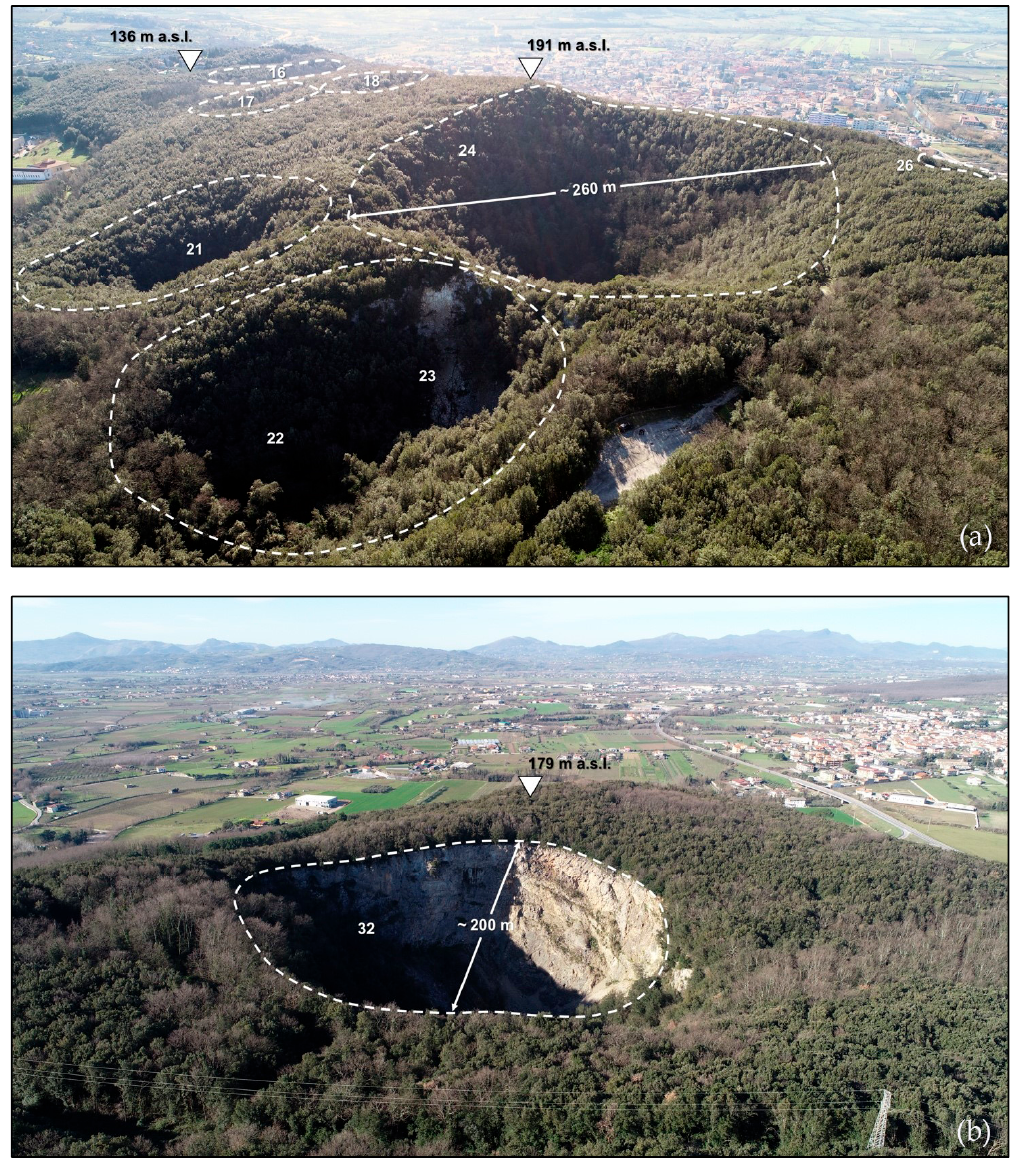
Figure 6. Drone images ( a ) and ( b ) of Montepugliano sinkholes. Dashed white lines represent the sinkhole rim. Item sinkhole numbers (16, 17, 18, 21, 22, 23, 24, 26, and 32) coincide with those in Figure 5 and Table 2.